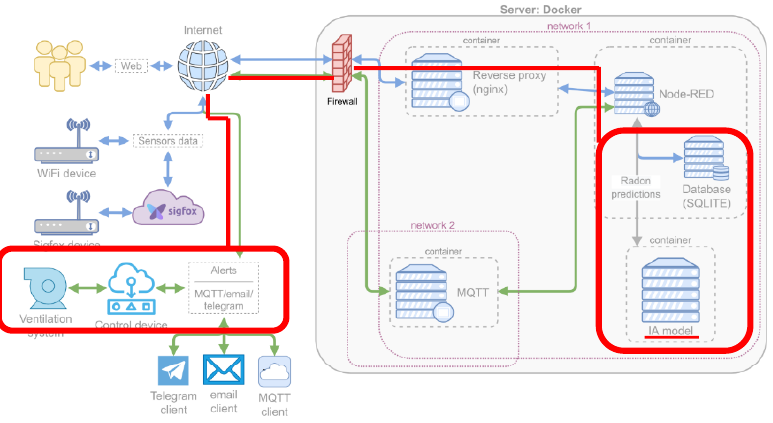
Figure 4. General scheme and ventilation system.